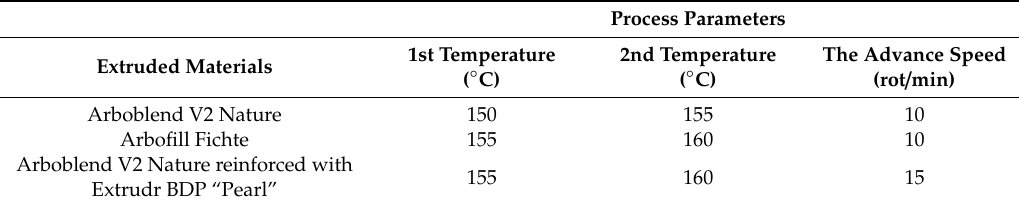
Table 1. The parameters’ values used for biodegradable material